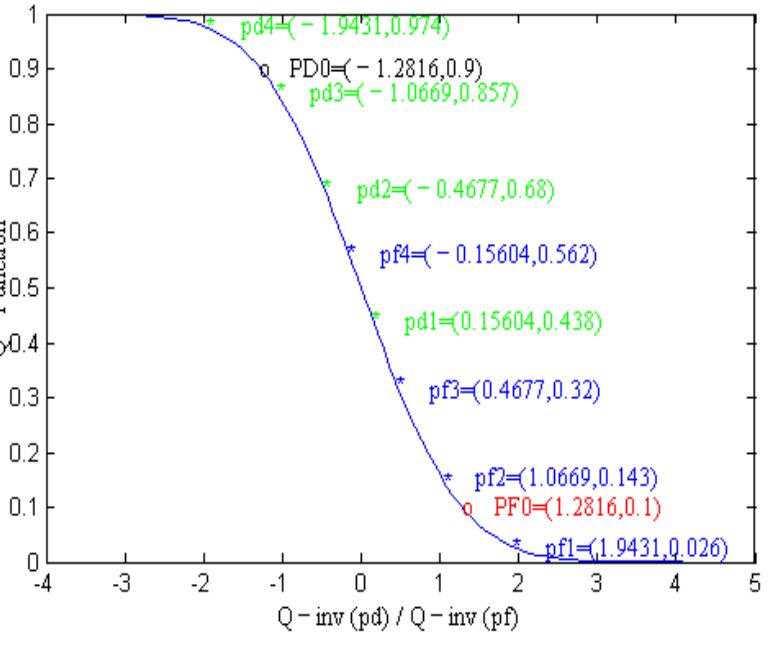
Figure 3. Detection performance with different values of k . Figures 4 and 5 indicate the impact of the idle and active ratio on the optimization, respectively. Figure 4 draws the contour lines of different µ ∗ thresholds, which reflect the target sensing performance. It is observed that at the same µ ∗ value, if the target detection probability P d 0 increases, then the target false alarm probability P f 0 can be relaxed (i.e., increased). In this figure, when µ ∗ reaches 7.7884 where a low presence of the PU occurs, P P ∗ also d 0 performs no better than 0.812, whereas f 0 exceeds 0.454. In return, a higher µ contributes to a larger EE. Figure 5 shows an example of the three-dimensional curve of EE. We observe that EE increases with µ until the threshold µ ∗ = 5.044 (the red line Figure 5) is reached at P d 0 = 0.9, P f 0 = 0.5, k = 3. For a specified µ ∗ , a unique peak of EE can be found by implementing the bisection search on the sensing ratio axis.